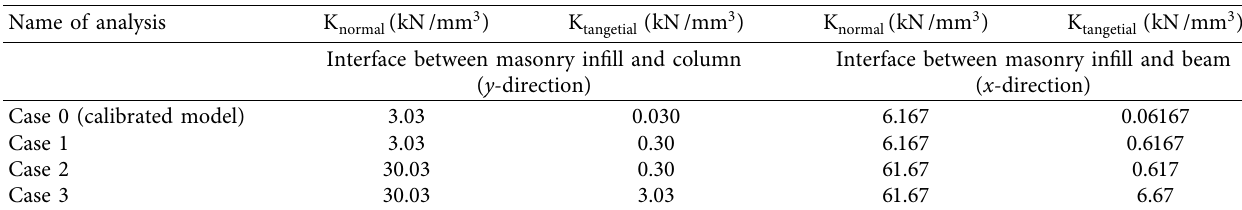
Figure 9: (a) Damage at the first storey on the east column in the experimental study, (b) cracking of the masonry at the first storey in the experimental study, and (c) crack patterns in the numerical model in the masonry infill in the first floor at the end of the Table 5: Number of trials for normal and tangential stiffness of the interface.